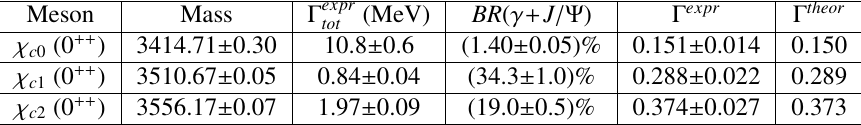
Table 3. Estimated dominant one-photon radiative decay widths Γ ( χ cJ → J / Ψ + γ ) (in units of MeV) of the charmonium orbital excitations in comparison with the recent experimental data [2]